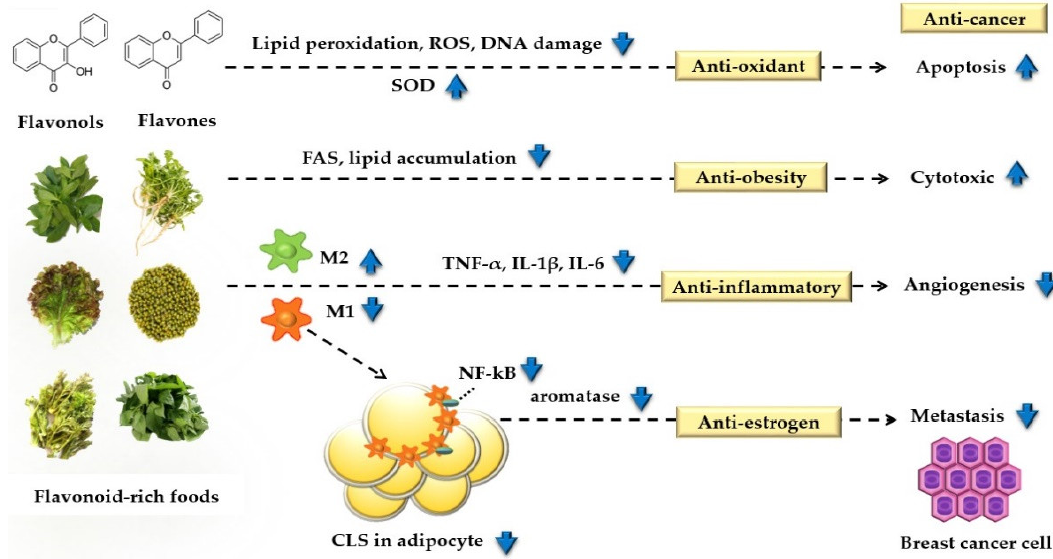
Scheme 1. Schematic diagram of the antioxidant, anti-obesity, anti-inflammatory, and anti-estrogen pathways regarding the effect of flavonoids on obesity-induced breast cancer. SOD, superoxide dismutase; ROS, reactive oxygen species; FAS, fatty acid synthase; NF-κB, nuclear factor-κB; TNF-α, tumor necrosis factor-alpha; IL-6, interleukin-6; IL-1 β , interleukin-1 β ; CLS, crown-like